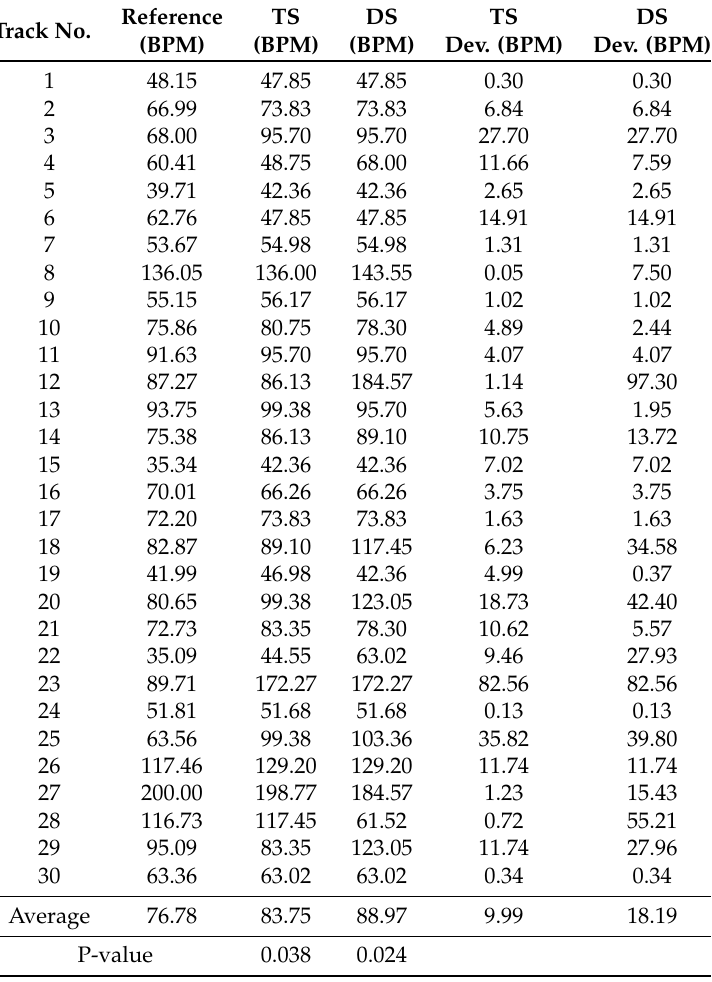
Table A2. Reference GT and computed GT of the reference database. Track